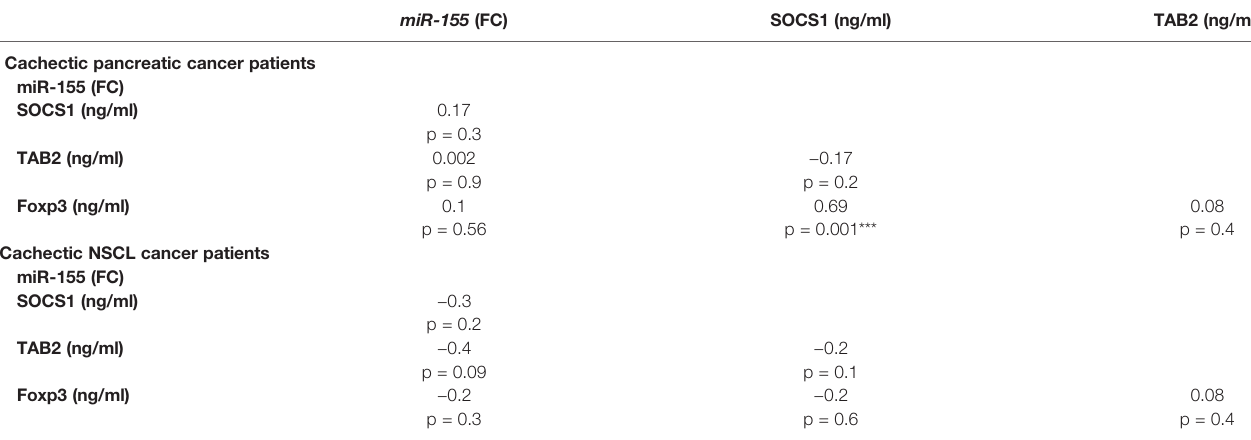
TABLE 6 | Correlation analysis between miR-155 gene expression and SOCS1, TAB2, and Foxp3 in cachectic pancreatic or NSCL cancer patients (Spearman ’ s correlation). miR-155 (FC) SOCS1